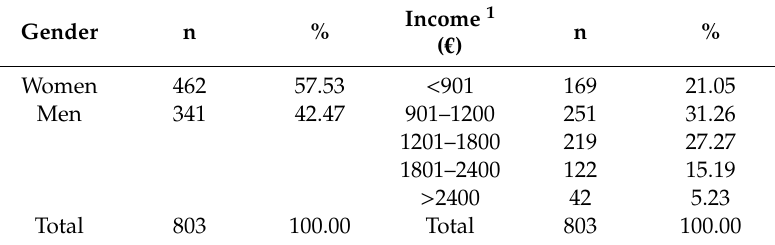
Table 1. Sample distribution.